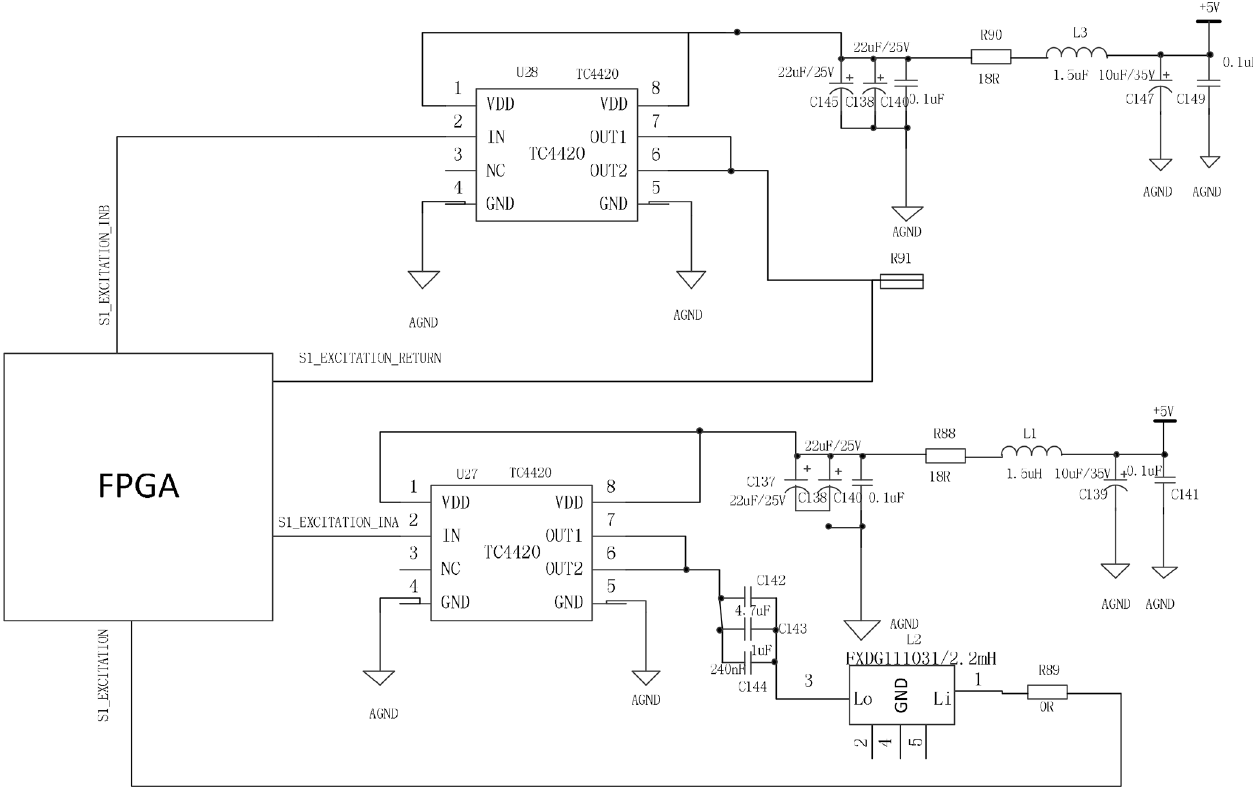
Figure 3. The schematic of the excitation module circuit.